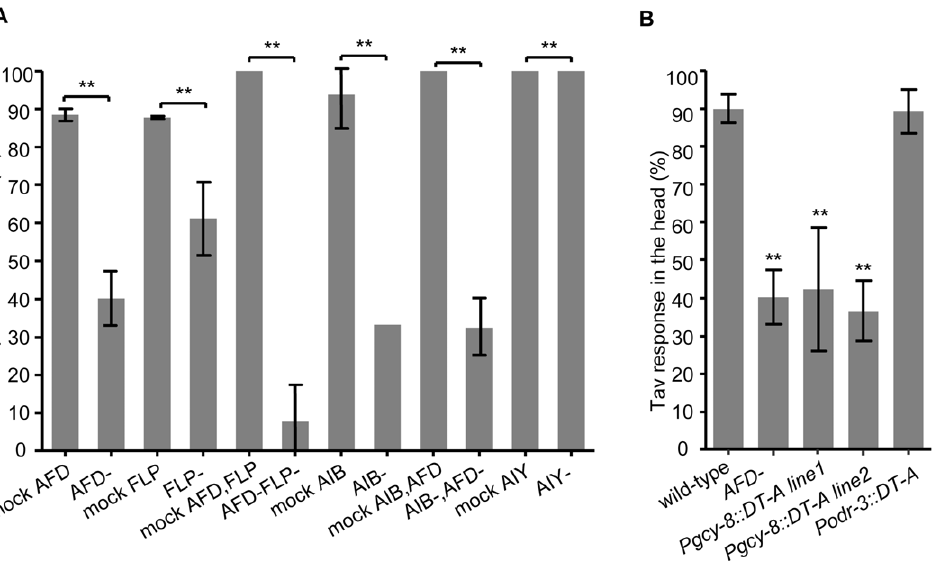
Figure 1. The AFD and FLP sensory neurons mediate Tav response in the head. (A) Laser ablation of AFD, FLP and AIB led to severe defects in the head Tav response compared to mock-ablated animals (n . 8). Individual neurons were identified by GFP-labeling and the success of the ablations was visualized by the disappearance of the GFP label in these neurons. Tav responses of the mock-ablated animals slightly differed, which is perhaps due to different GFP transgenes (see Methods). (B) AFD-laser-ablated and two transgenic lines [expressing Diphtheria Toxin A (DT-A) under the control of the gcy-8 promoter] in which AFD was genetically ablated showed defective head Tav response, whereas DT-A killing of five pairs of sensory neurons (from the odr-3 promoter), but not AFD, behaved like wild-type (n . 80). (**P , 0.001). Error bars indicate SD.